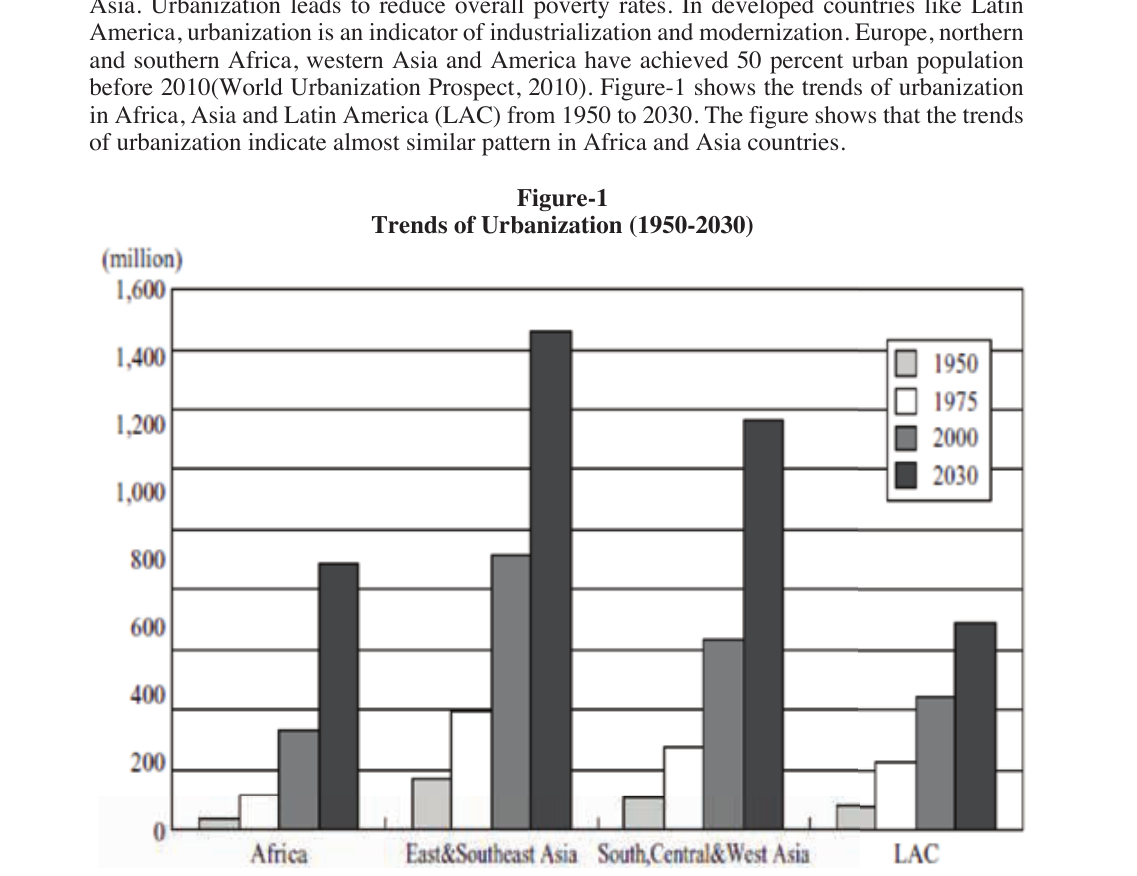
Figure-1 Trends of Urbanization